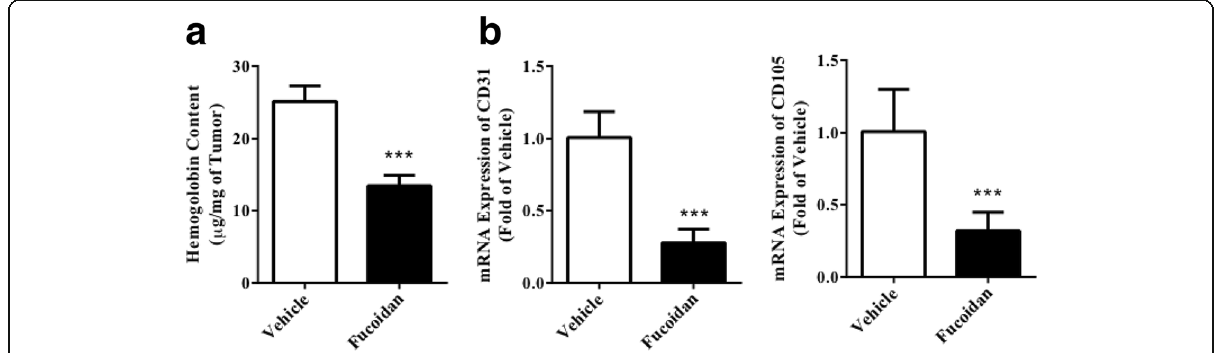
Fig. 4 Fucoidan inhibited angiogenesis in tumor tissue. Tumor tissue from prostate cancer xenograft was isolated and homogenized for angiogenesis analysis. a Hemoglobin content determined by colorimetric method. b mRNA expression of CD31 and CD105 determined by real-time PCR. *** P < 0.001 vs. vehicle group. N = 6 for each